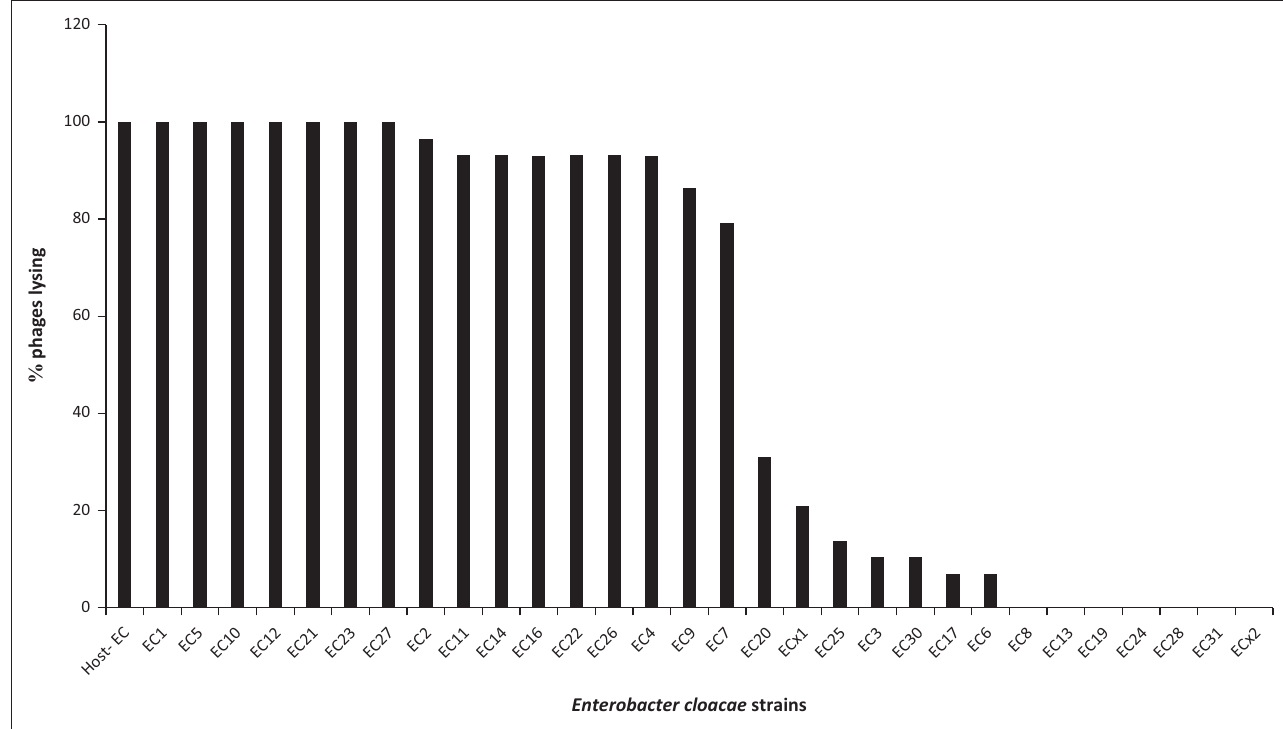
FIGURE 7: Susceptibility of Enterobacter cloacae bacteria to isolated phages in Nairobi County, Kenya, July 2019 to December